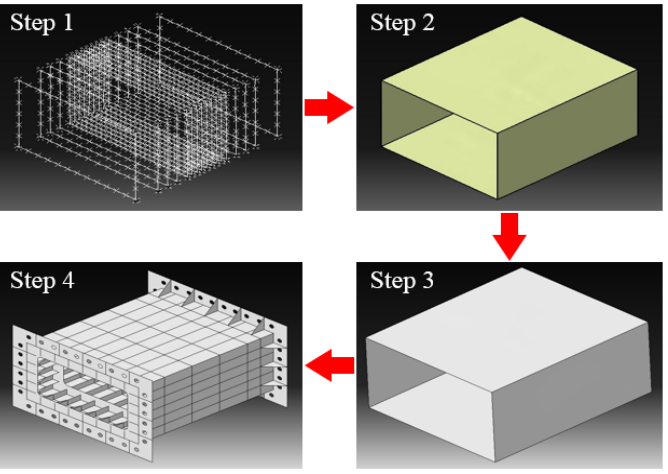
Figure 17. The process of FE modeling considering the initial shape imperfection.